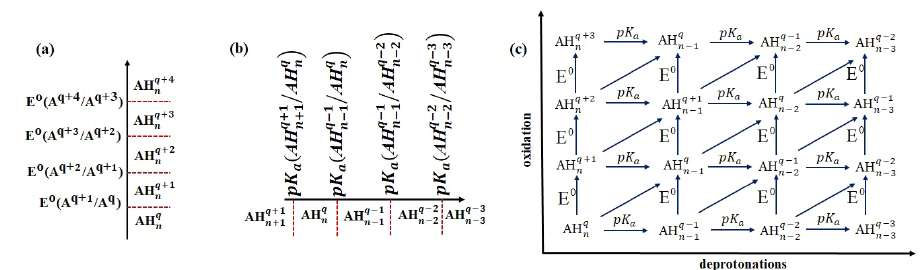
Fig. 2. – (a) Schematic description of each charge state for a potential domain with the cor- responding reduction potentials. (b) Schematic depiction of each protonation state for the p H region of stability with the corresponding pK a values as boundaries. (c) Schematic descrip- tion of the two-dimensional phase diagram based on the oxidation-reduction and protonation- deprotonation